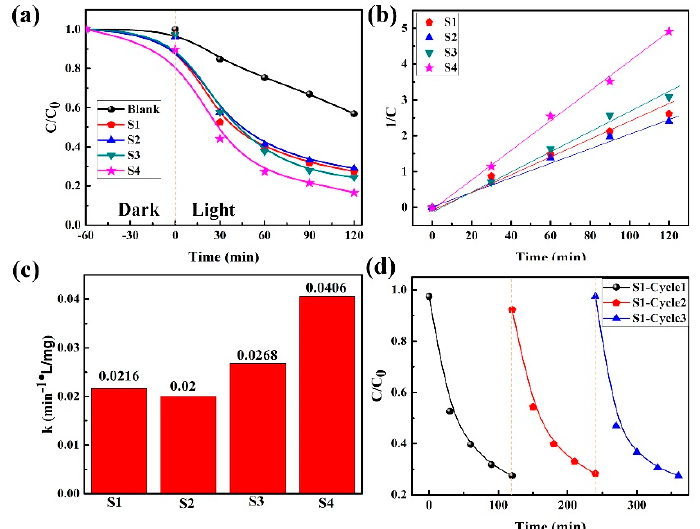
Figure 6. ( a ) Photocatalytic degradation of TC with as-prepared samples under UV light irradiation. ( b ) Plot based on simple second-order kinetic model for TC degradation with the as-synthesized samples S1, S2, S3, and S4. ( c ) Kinetic constants for photocatalytic degradation of TC. ( d ) Cycling experiments of sample S1 for TC degradation.